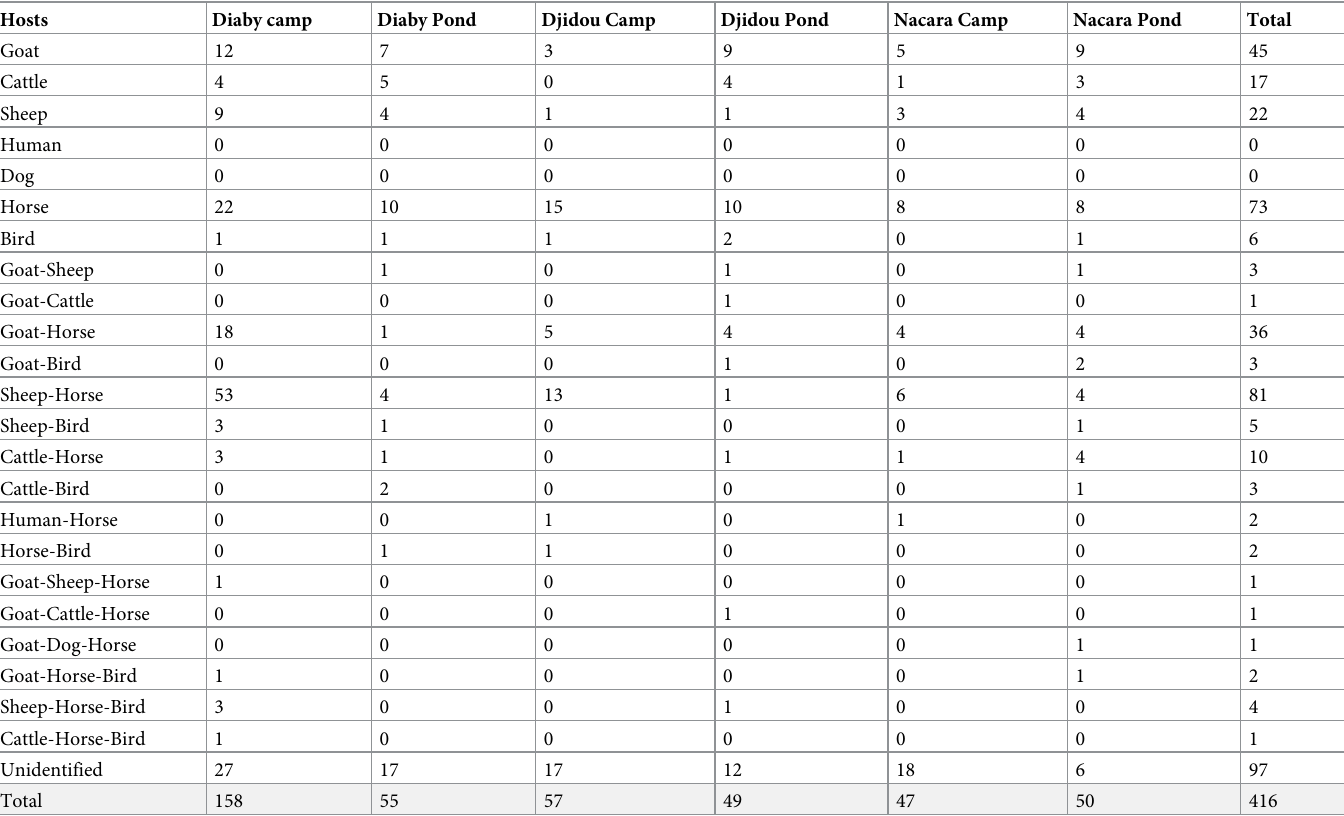
Table 2. Origin of blood meals taken by Aedes vexans arabiensis females collected at different sites. Hosts Diaby camp Diaby Pond Goat Cattle Sheep Human Dog 0 Horse Bird Goat-Sheep Goat-Cattle Goat-Horse Goat-Bird Sheep-Horse Sheep-Bird Cattle-Horse Cattle-Bird Human-Horse 0 Horse-Bird Goat-Sheep-Horse 1 Goat-Cattle-Horse Goat-Dog-Horse 0 Goat-Horse-Bird Sheep-Horse-Bird Cattle-Horse-Bird 1